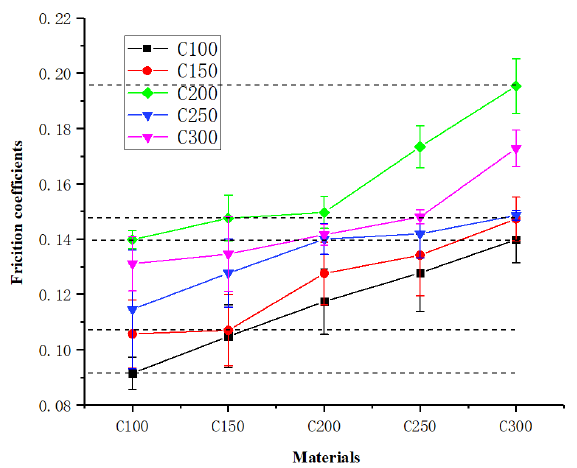
Figure 6. Friction coefficients of BHSIMs (phase I is labeled on the X -axis and phase II is indicated by legends).